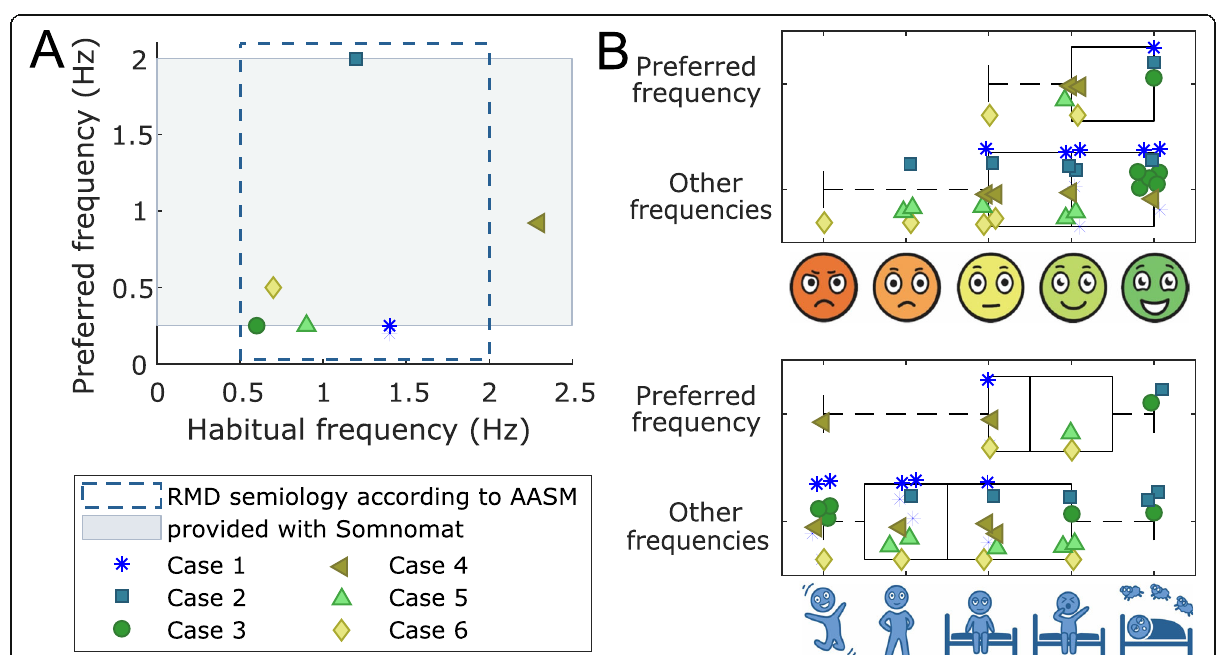
Fig. 2 Outcome of the movement preference protocol regarding frequency of the bed movement ( n = 6). A. Habitual movement frequency while making rhythmic movements vs. the preferred bed frequency as determined during the preference protocol. Area indicated in blue shows the frequency range of rhythmic movement disorder (RMD) reported by the American Academy of Sleep Medicine (AASM). Area shaded grey shows the range of frequency provided using the Somnomat. B. Boxplots of comfort (top) and sleepiness (bottom) at the preferred bed frequency and all other frequencies